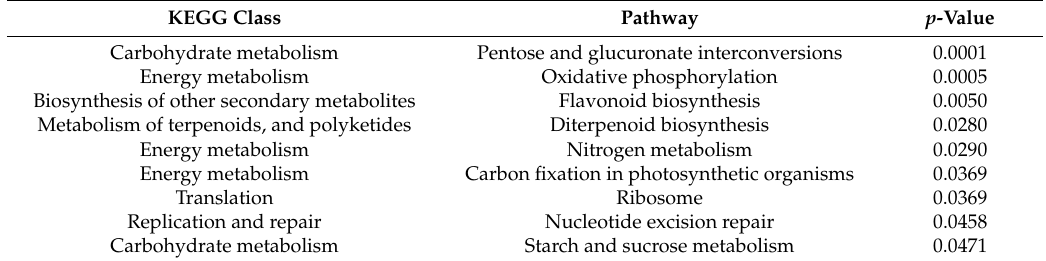
Table 5. KEGG terms enriched among upregulated DEGs specific to the PS vs. PT comparison.